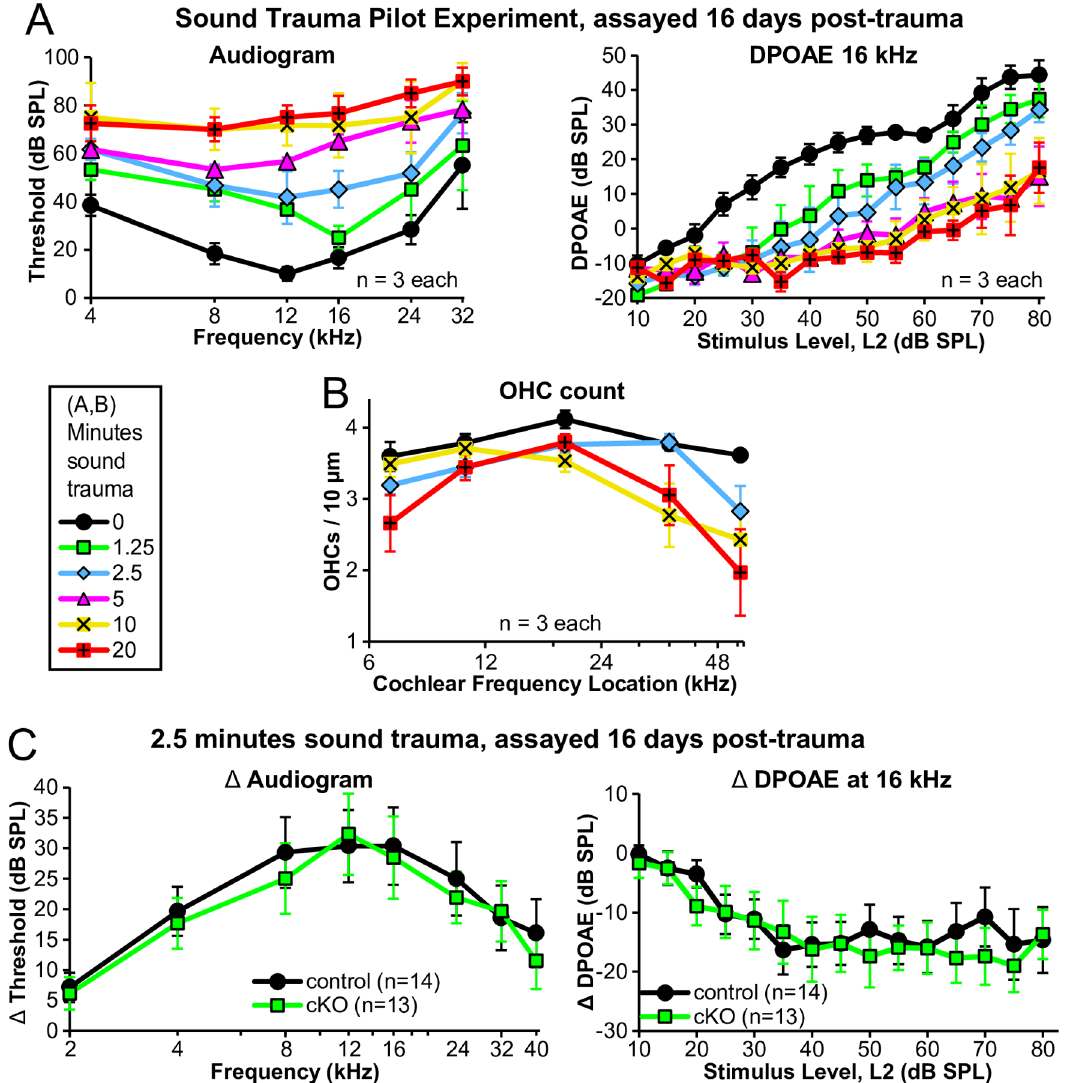
Fig 5. C1ql1 cKO and control mice have indistinguishable susceptibility to acoustic trauma. (A, B) Auditory thresholds, DPOAEs, and OHC survival were tested on 8-week-old C1ql1 flox/flox mice after varying durations of acoustic trauma. 120 dB SPL of sound was presented at 8–16 kHz to anesthetized mice. N = 3 for each duration. Assays were conducted 16 days post-acoustic trauma. DPOAEs were also tested at 8, 12, and 24 kHz but these data did not add to the interpretation. (C) 2.5 min of acoustic trauma to 8-week-old control and cKO mice revealed no differences between genotypes in the audiogram or DPOAEs 16 days post- trauma. DPOAEs were also tested at 8, 12, and 24 kHz, with no differences between genotypes observed (not shown). Data are presented as mean ±